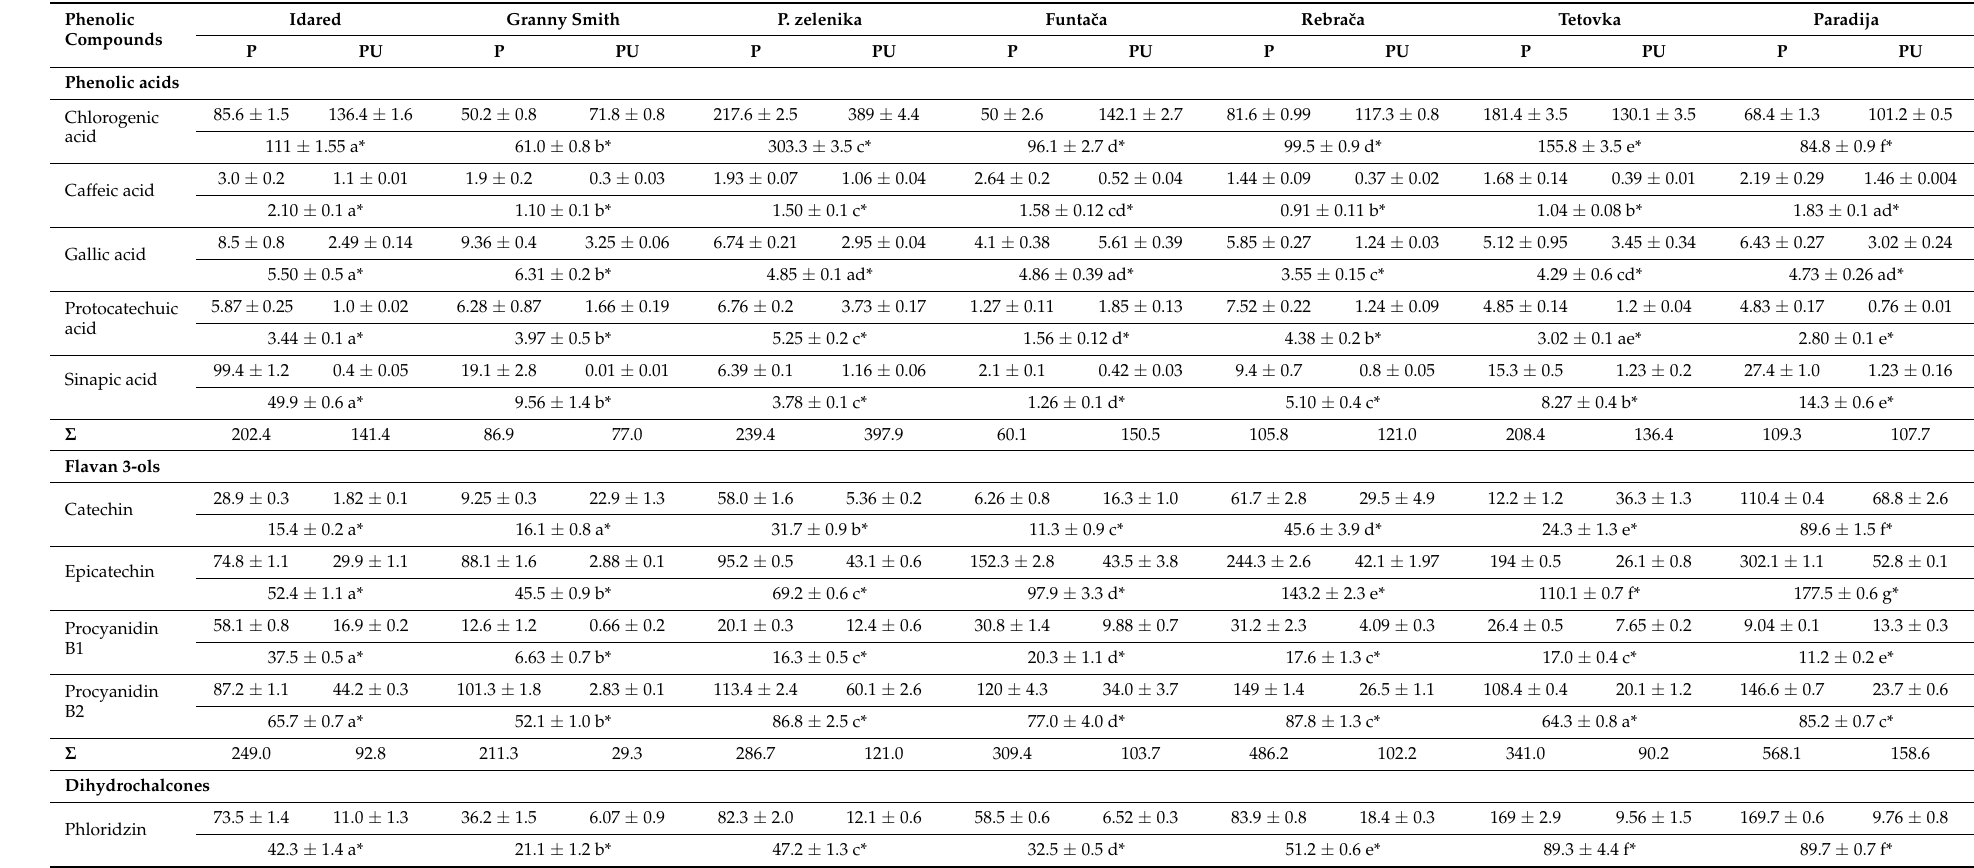
Table 1. Average content of individual polyphenolic compounds in apple cultivars (mg kg − 1 of FW) ± standard deviation (SD). Phenolic